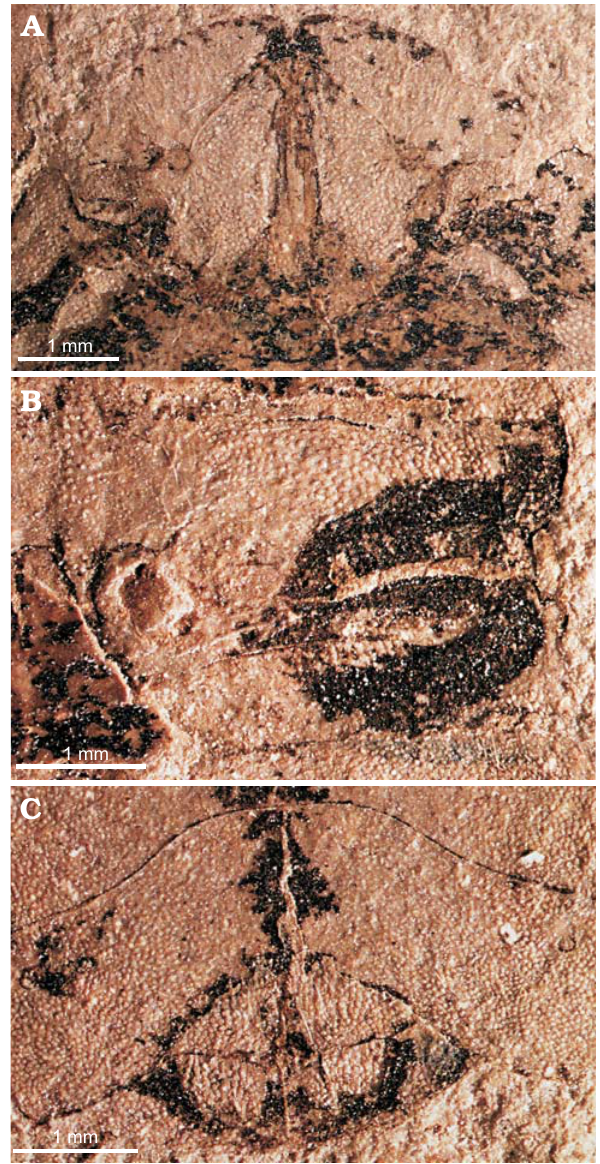
Fig. 4. Details of ventral habitus of female of pentatomoid bug Chinche- koala qunita gen. et sp. nov., holotype MPEF-PI 944b from Laguna del Hunco (Chubut, Argentina); Ypresian, lower Eocene. Head ( A ), thoracic scent efferent system ( B ), genitalia ( C (Fig. 4B; Petr Kment personal communication 2016). This character is only present sensu Kment and Vilímová (2010a) in Thaumastellidae, Cydnidae, Thyreocoridae, Parastrachiidae, Phloeidae: Phloeinae, Plataspidae, and Dinidoridae (partim). All these taxa except the Cydnidae had been excluded by other previously cited characters. Some cydnids have a broad head and the mandibular plates touching each other in front of the clypeus (see Lis and Heyna 2001: fig. 49), but there are no genera with anteocular processes. Unfortunately, the specimen does not preserve the legs, and thus it is unknown if they were spiny, like in Cydnidae (Petr Kment personal communication 2016), which precludes its attribution to this family awaiting a specimen with preserved legs.